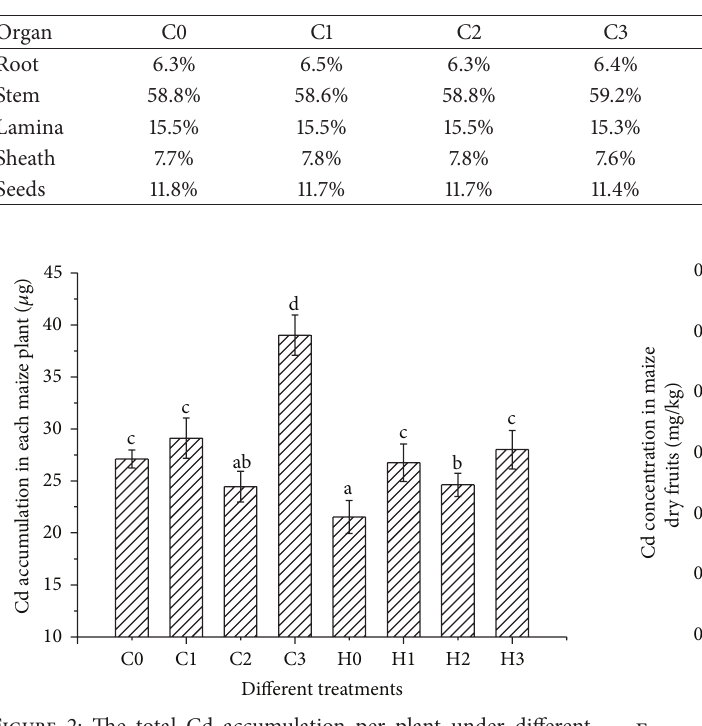
Figure 2: The total Cd accumulation per plant under different treatments. All values are mean ± SD ( 𝑛 = 3 ). Values labeled with different letters are significantly different from each other at 𝑃 ≤ 0.05 . The codes for different treatments in horizontal axis were correspondent to Table 2.